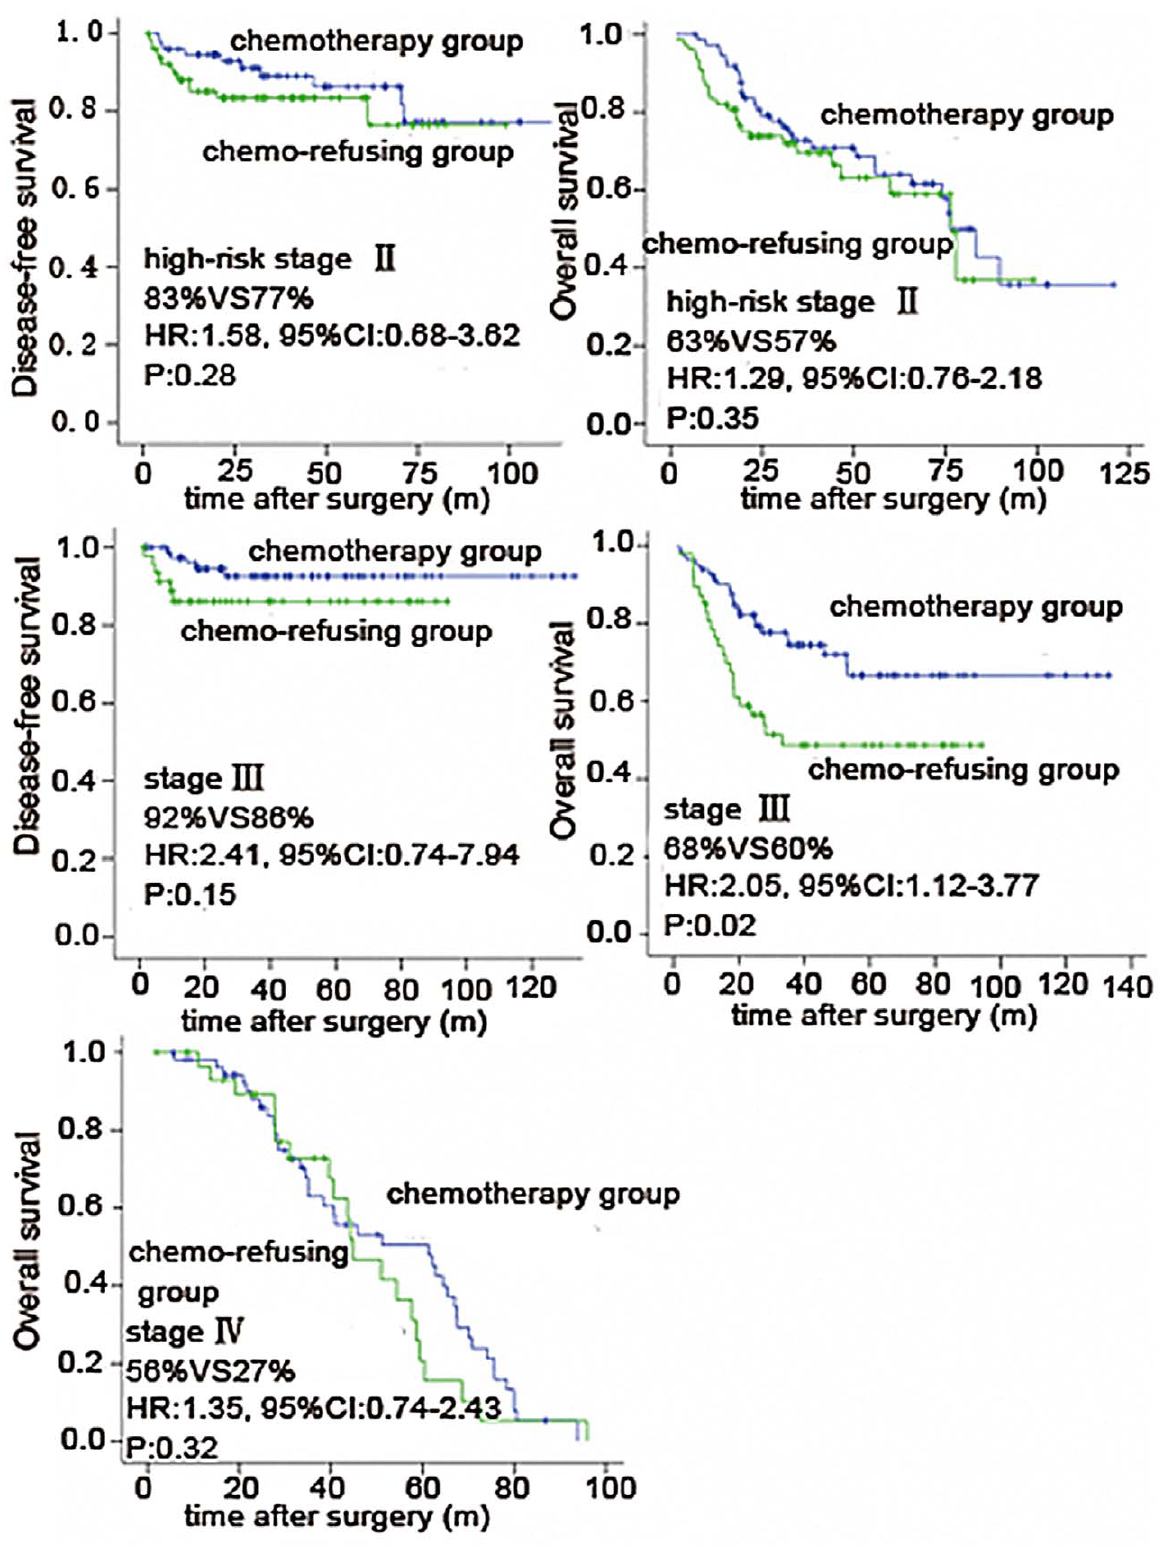
Figure 2. Relationship between survival and chemotherapy.